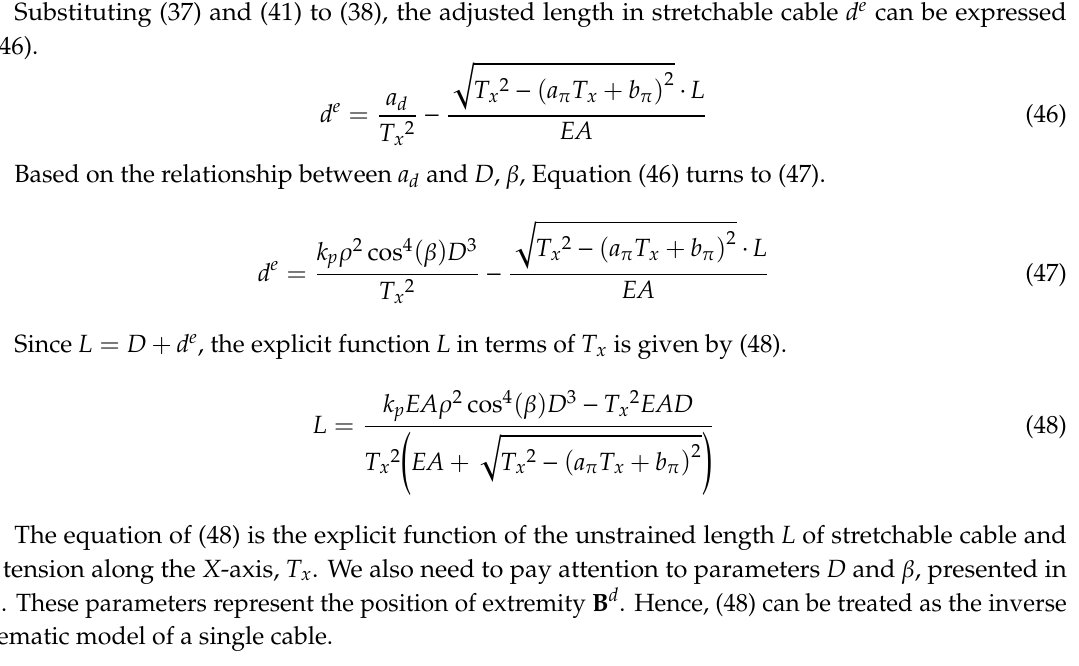
Figure 15. The relationship between p q and ρ